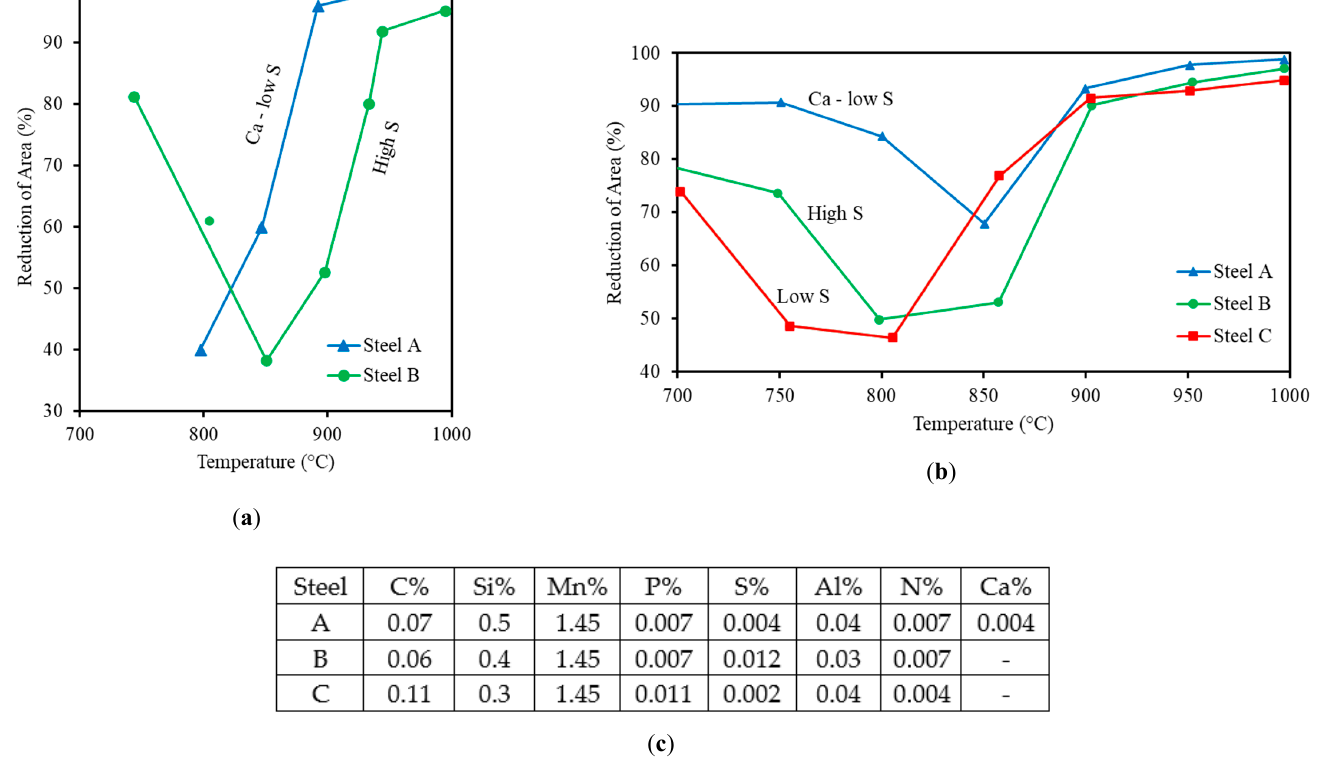
Figure 18. Hot ductility curves for steels with and without Ca additions. ( a ) steels cast in situ, ( b ), Solutions treated at 1300 °C ( c ) a table giving the composition of the steels [21]. Adapted from [21], with permission from Taylor & Francis Group, 2022.